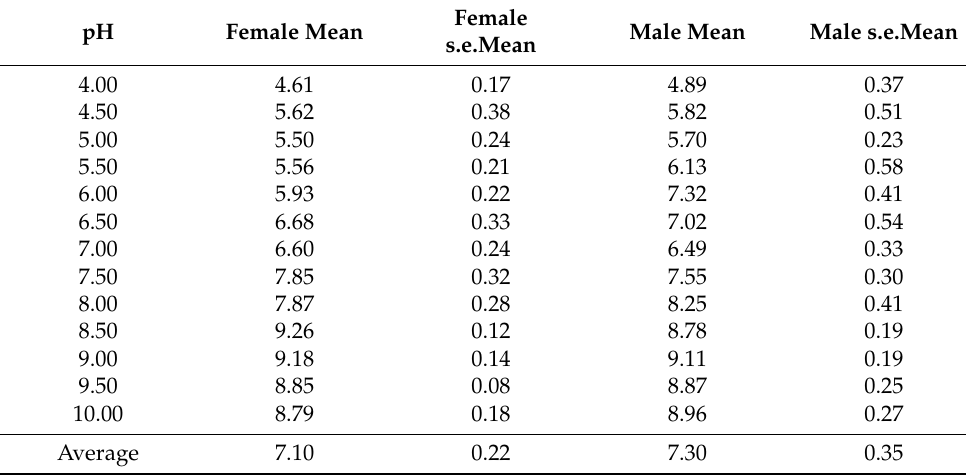
Figure 2. Estimated pH from test kit against laboratory derived pH for male ( ▲ ) and female ( ○ ) groups showing strong linear correlation but divergent relationship at low pH. Error bars show +/ − standard error and 1:1 relationship shown by the dashed line. Table 1. Mean and s.e. results for pH values (4.00 to 10.00) for female and male groups.